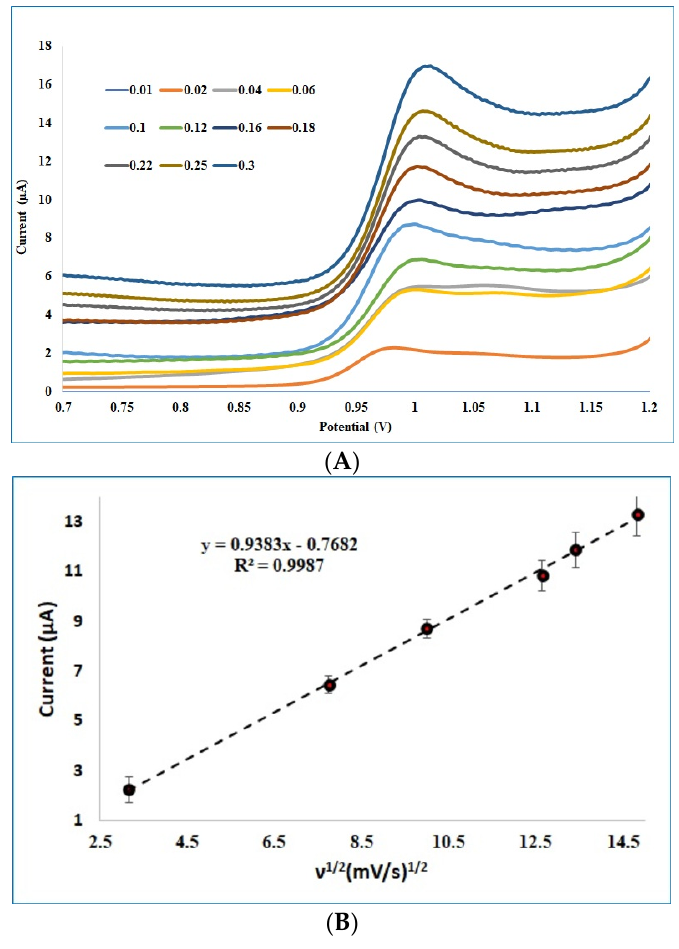
Figure 4 . Electro-oxidation of ABZ at Pt-Pd-modified GCE. ( A ) Linear scan voltammograms of ABZ at different scan rates from 0.01 to 0.3 V s -1 . ( B ) Dependence of the oxidation peak current on the square root of the scan rate.